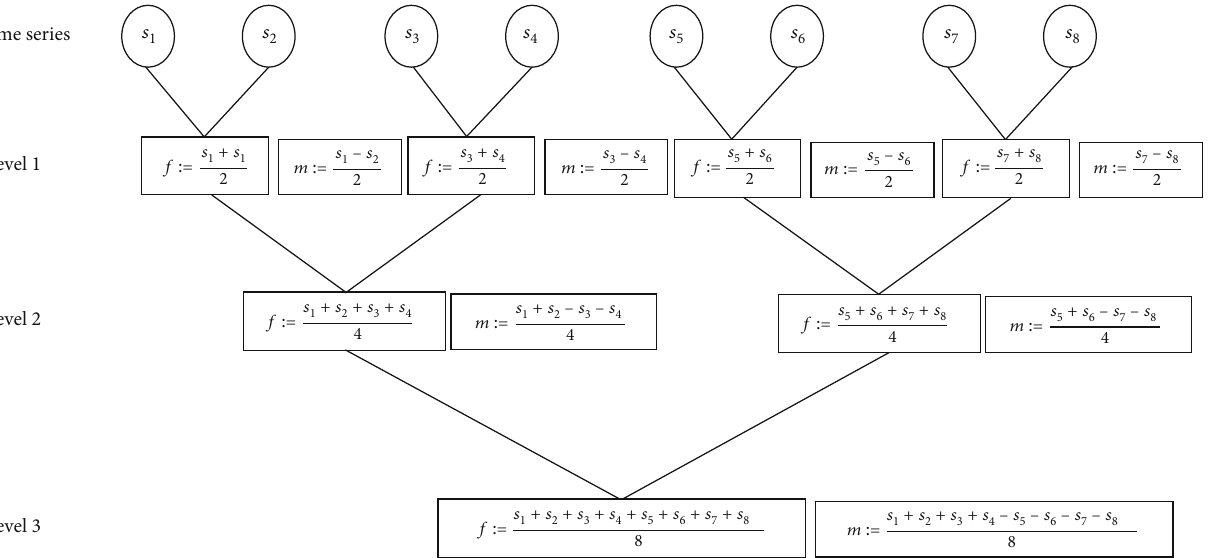
Figure 3: Illustration of H